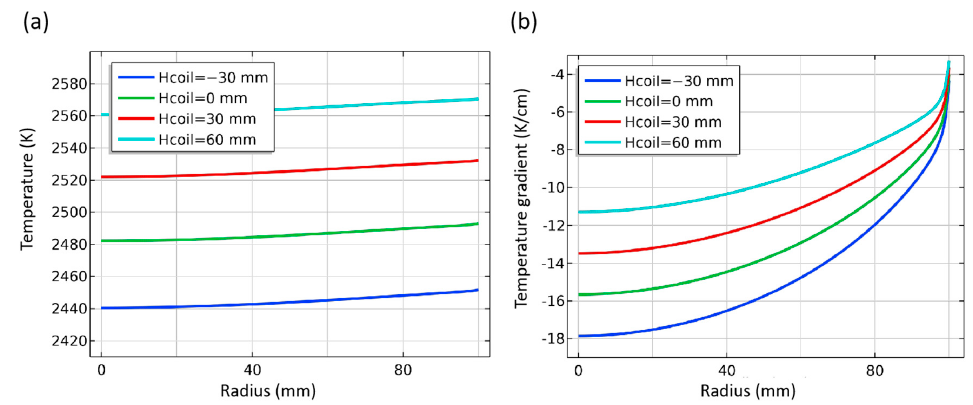
Figure 14. Temperature and temperature gradient at different coils height. ( a ) Temperature along surface of seed crystal; ( b ) Temperature gradient around seed crystal.